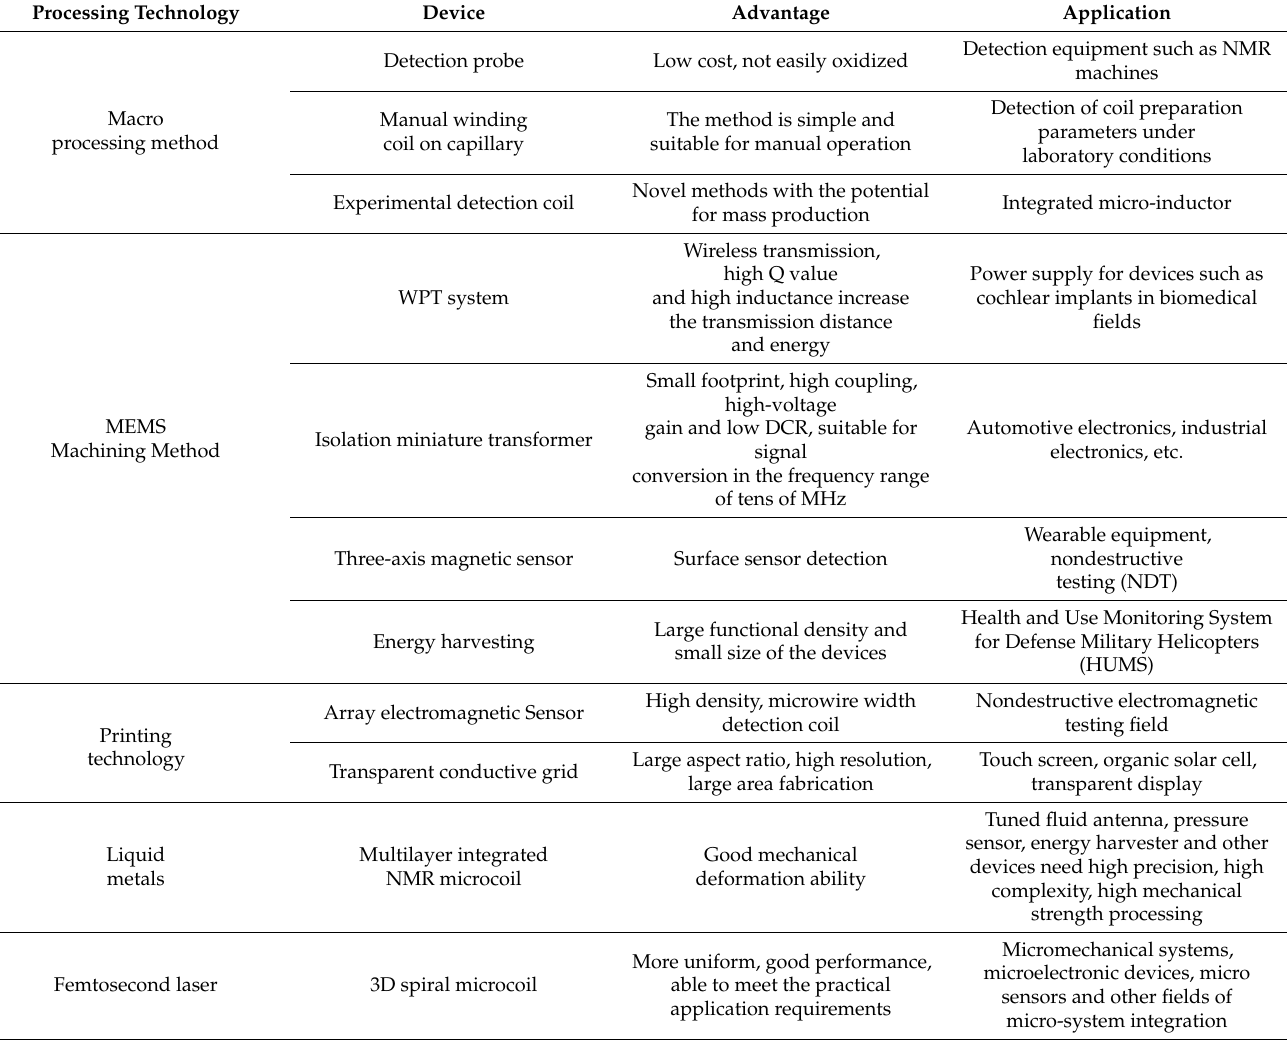
Table 9. The performance and practical applications of coils prepared based on different processes. Processing